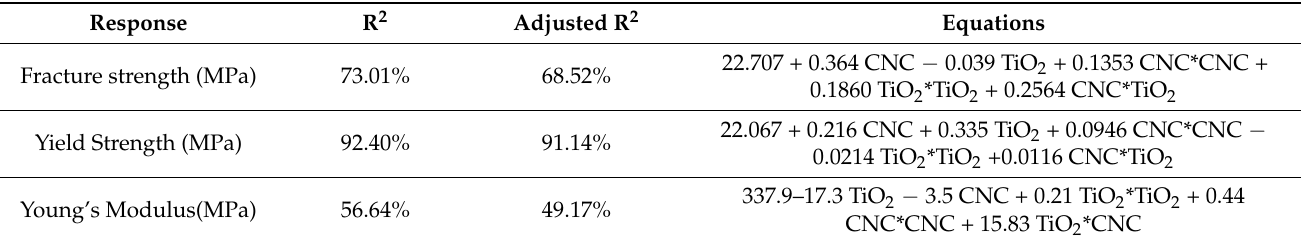
Table 6. Summarized predicted mechanical properties of the HDPE nanobiocomposites by using RSM equations.